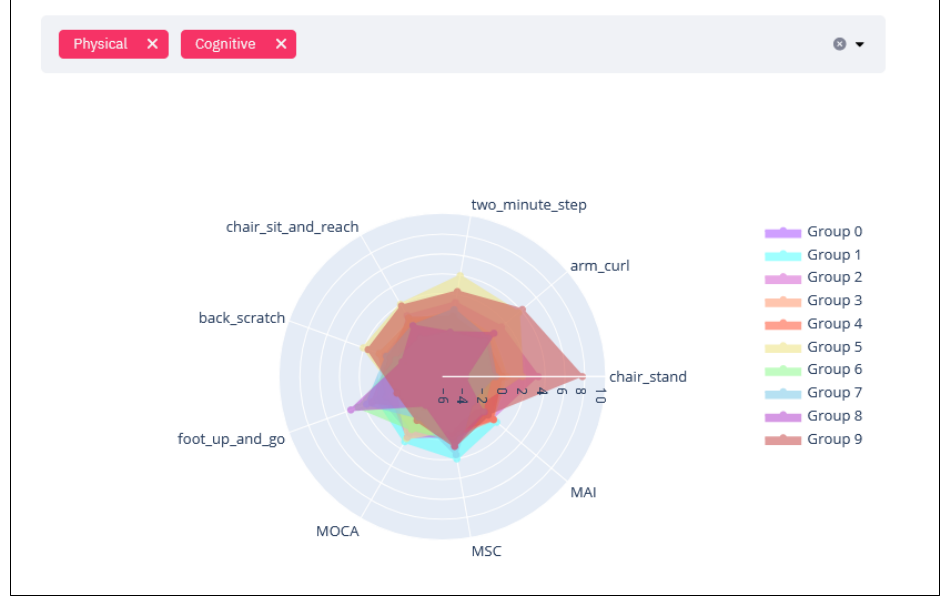
Figure 5. Radar chart of the clusters obtained in Figure 3. In this case it shows the variables associ- ated with the Physical and Cognitive fields.